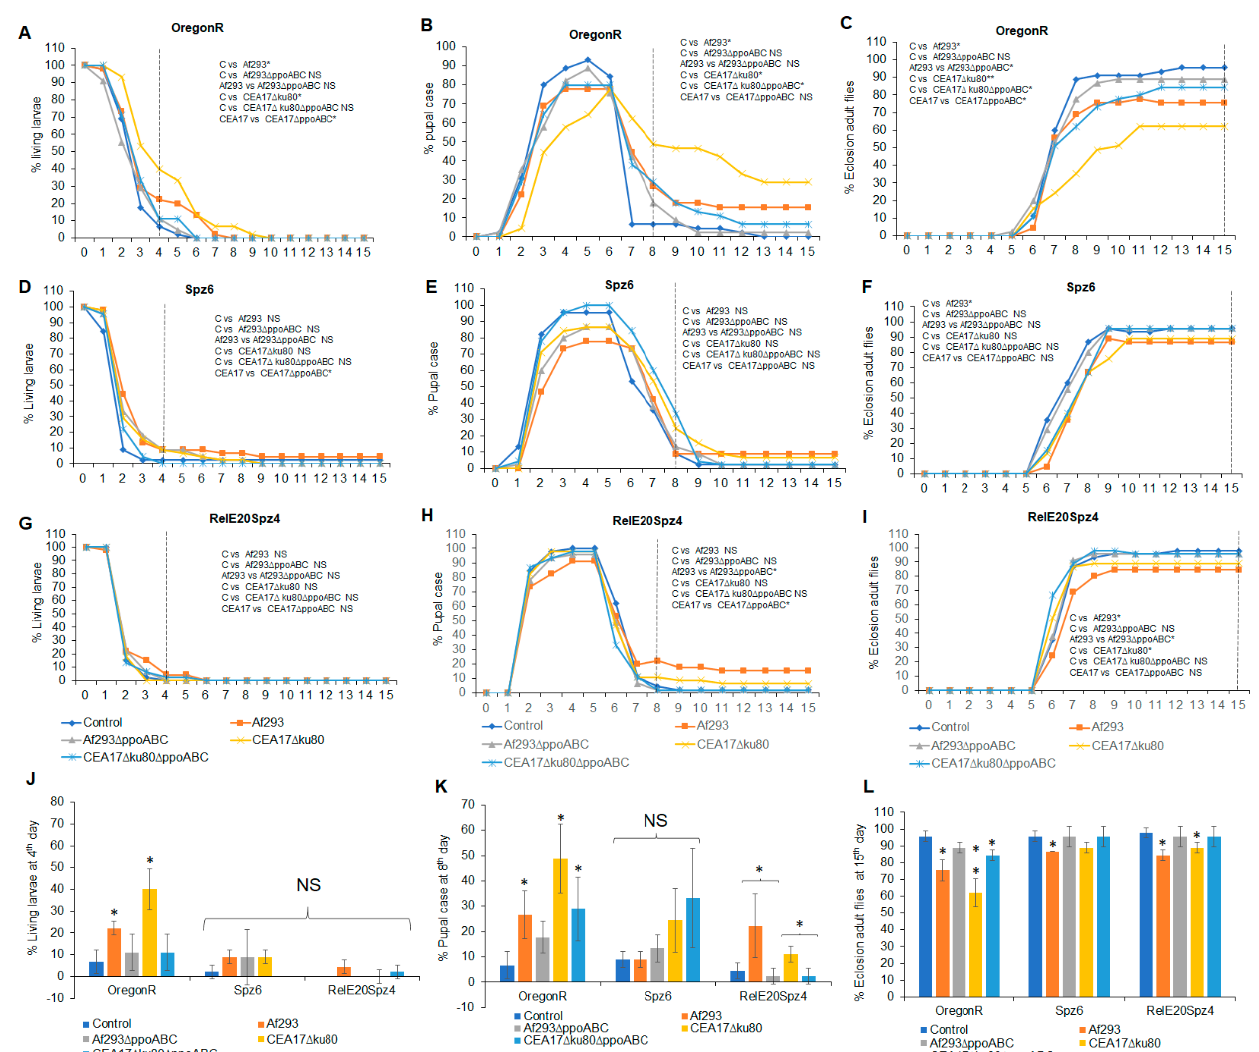
Figure 3. Effects of VOCs emitted from four different A . fumigatus strains pre − grown on PDA at 25 ◦ C for 5 days on the third instar red − eyed fly larvae over 15 days of continuous exposure. The percentages of living larvae, pupal case, and eclosion adult flies are as follows: Oregon R living larvae ( A ), Spz 6 larvae ( D ), and Rel E20 Spz 4 larvae ( G ); Oregon R pupal case ( B ), Spz 6 pupal case ( E ), and Rel E20 Spz 4 pupal case ( H ); and Oregon R eclosion adult flies ( C ), Spz 6 eclosion adult flies ( F ), and Rel E20 Spz 4 eclosion adult flies ( I ). The statistical analyses were performed for the living larvae on the 4th day ( J ), the pupal case on the 8th day ( K ), and the eclosion adult flies on the 15th day ( L ). A dashed vertical line denotes the days for statistical analysis (N = 180). * Represents the significant differences between different treatments, where 0.005 < * p < 0.05, 0.0005 < ** p < 0.005; NS, p > 0.05.